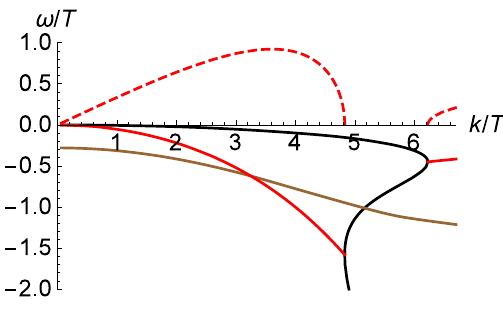
Figure 8 . The lowest CMs at (cid:22)=T (cid:25) 1 : 9, m = 0 : 1 and (cid:12) = 4 (cid:25) . Dashed lines are real parts and solid lines are imaginary parts. Sim- ilarly coloured real parts and imaginary parts constitute the same mode. The black line is purely di(cid:11)usive (and technically (cid:12)ve di(cid:11)er- ent modes). Note that the !=T -axis is scaled quadratically to better display all modes, but also to showcase the quadratic imaginary part of the linear mode.